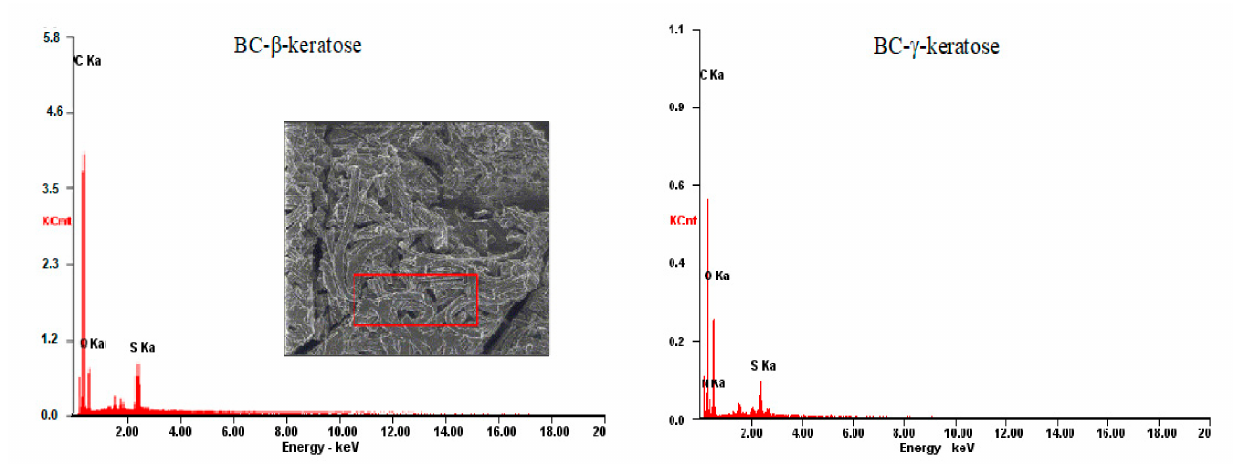
Figure 6. EDAX elemental analysis of the BC-keratoses scaffolds. Table 2. Elemental weight value for BC-keratose scaffolds.